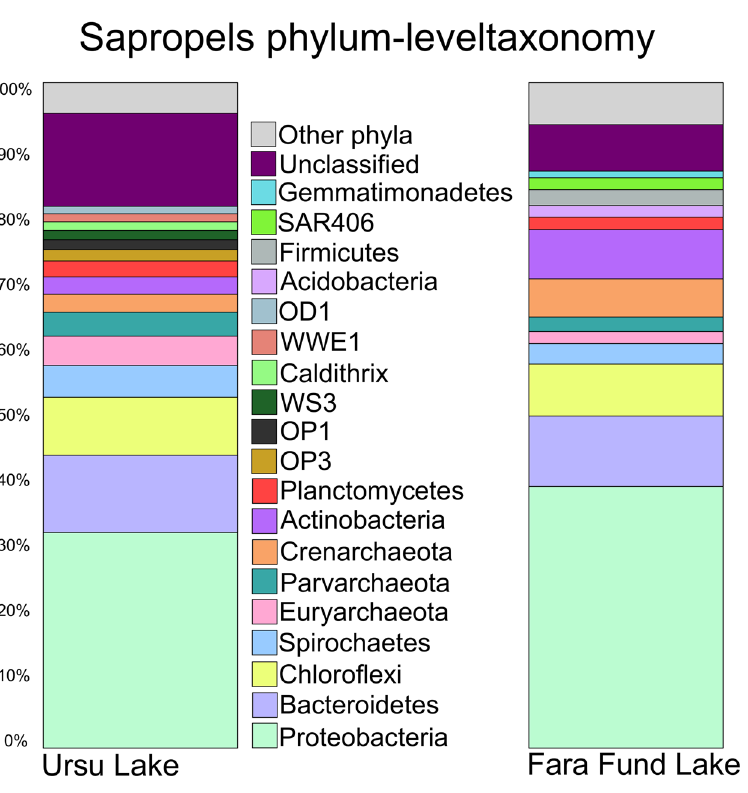
Figure 3. Phylum-level taxonomic profiles of sapropels prokaryotic communities using 16 S rRNA gene